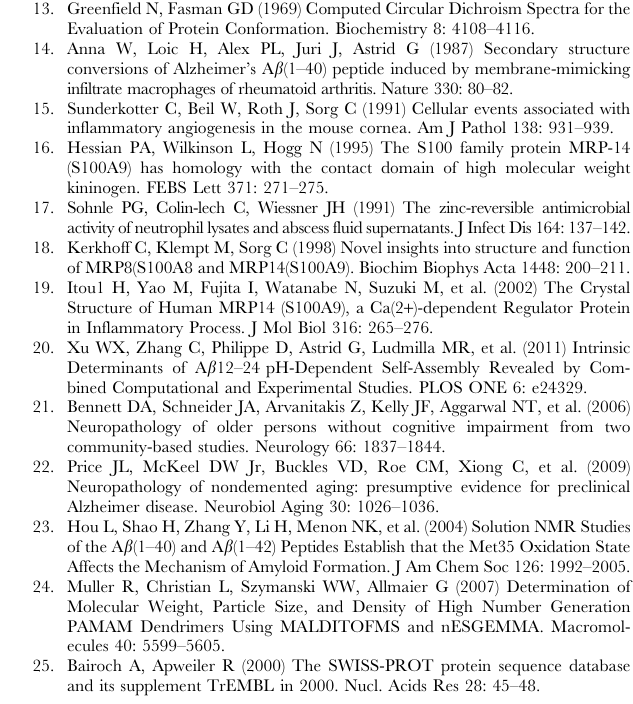
Figure S6 AFM images of (a) A b 12–24 peptide (0.2 mM) incubated at pH 7.4 and 37 0 C for 3 d; (b) the mixture of freshly dissolved A b 12–24 peptide (0.2 mM) and S100A9 protein (0.02 mM) incubated at pH 7.4 and 37 0 C for 3 d; (c) A b 1–42 peptide (0.2 mM) incubated at pH 7.4 and 37 0 C for 3 d; (d) the mixture of freshly dissolved A b 1–42 peptide (0.2 mM) and S100A9 protein (0.02 mM) incubated at pH 7.4 and 37 0 C for 3 d. In fig. a and b, the scale bars denote 100 nm in the figure, and 1000 nm in the insertion, respectively. The scale bars denote 200 nm in fig. c and 500 nm in fig. d. With the addition of S100A9, large quantities of A b 12–24 amyloid fibrils (2 nm in height) were formed, which is similar in size with the mature A b fibrils. In contrast, only protofibrils (0.5 nm in height) were observed with A b 12–24 control samples under the same conditions (panel a). Similarly, A b fibrils were only formed in the presence of S100A9 after 3 d incubation at pH 7.4 and 37 0 C. The average height of the fibrils in fig. d is 2 nm, which is close to the reported value for A b amyloid fibrils.